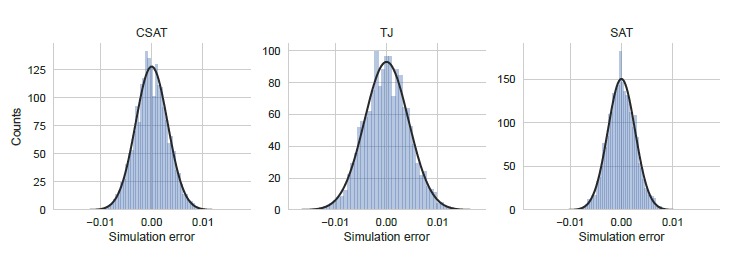
Distribution of simulation error.Simulation error was calculated as the deviation of the YFP synthesis rate from the mean across an ensemble of 5000 identically simulations for each of the three kinetic models considered in the manuscript. The yfp mutant in the simulation had two CTA stall sites at Leu2 and Leu14 as shown in Figure 5. YFP synthesis rate was calculated relative to the no-stall control. Black line indicates a Gaussian fit.